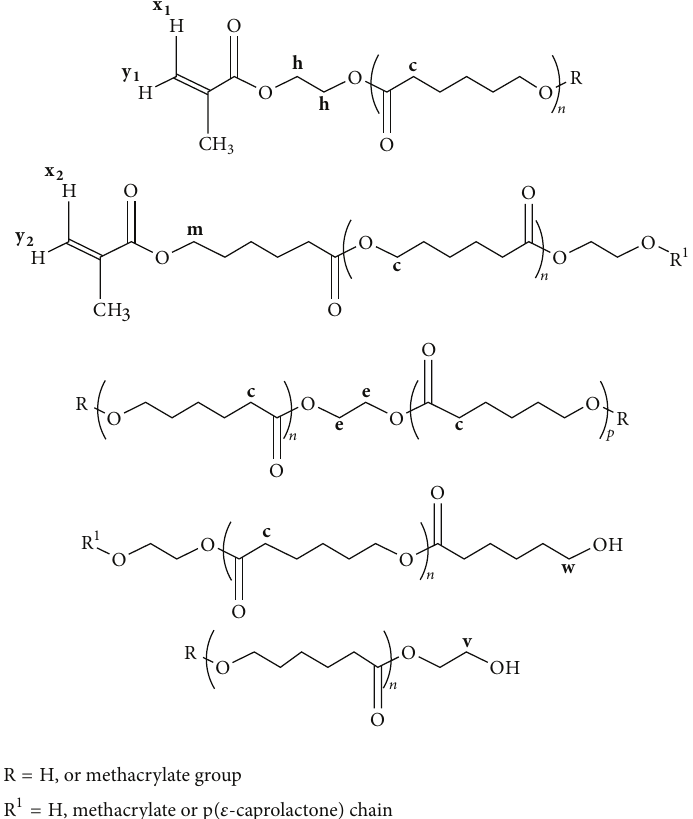
Figure 3: Proposed products obtained in enzymatic ring-opening polymerization of CL as HEMA is the initiator [12, 18].